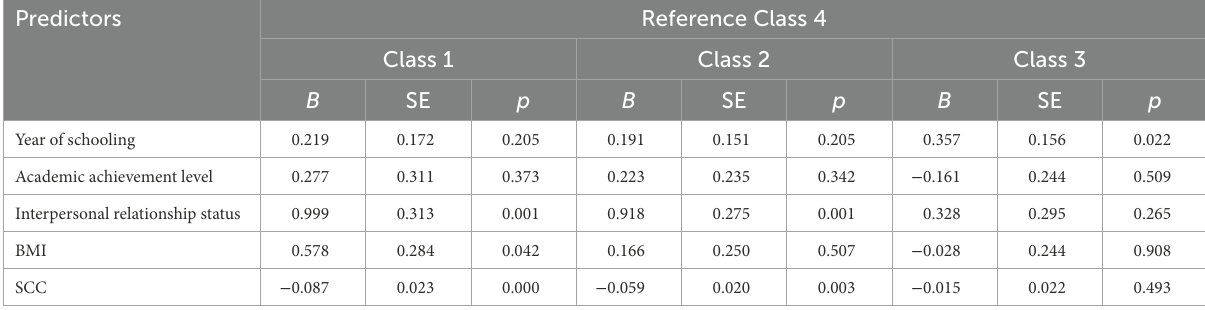
TABLE 4 Predictors of four profiles of body